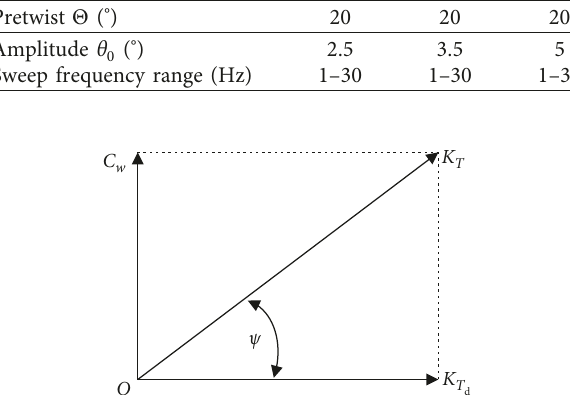
Table 2: Loading scheme for the dynamic torsion test of DMF.